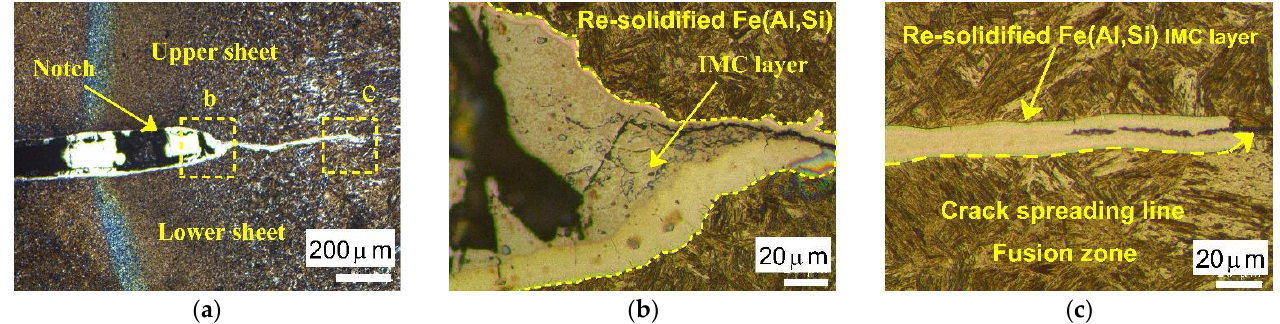
Figure 14. Optical image of weld nugget: ( a ) cross-section of weld nugget periphery; ( b ) enlarged image of region “b”; and ( c ) enlarged image of region “c”.